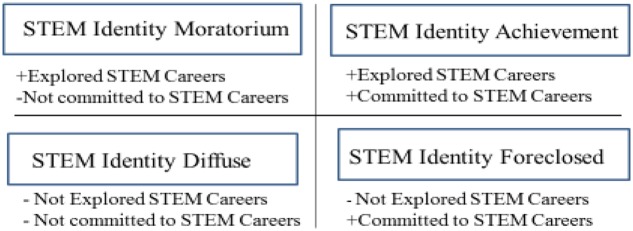
Science identity status based on Marcia’s (1980) identity status theory.